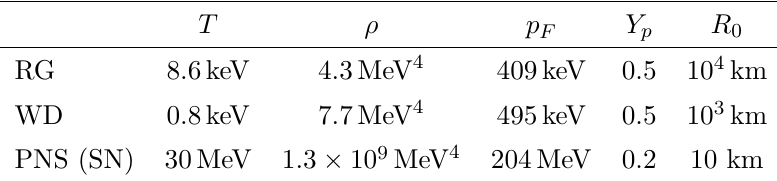
Table 2 . Numerical inputs used in the evaluation of the stellar cooling